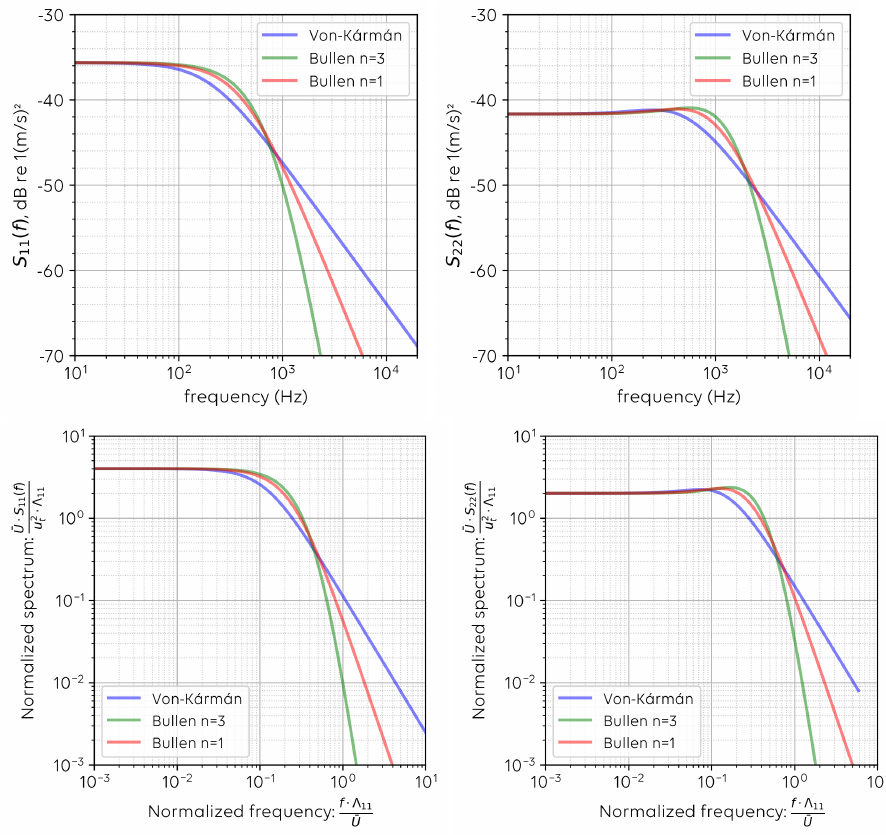
Figure 1. Synthetic turbulence spectrum of both longitudinal and transverse velocity components. Parameters used: U 0 = 34 m/s, Tu = 1%, ILS = 20 mm. Bullen and von Kármán turbulence models are displayed. ( Top-left ): PSD of the longitudinal velocity component S 11 ( f ) . ( Top-right ): PSD of the transverse velocity component S 22 ( f ) . ( Bottom-left ): PSD of the normalized longitudinal velocity component. ( Bottom-right ): PSD of the normalized transverse velocity